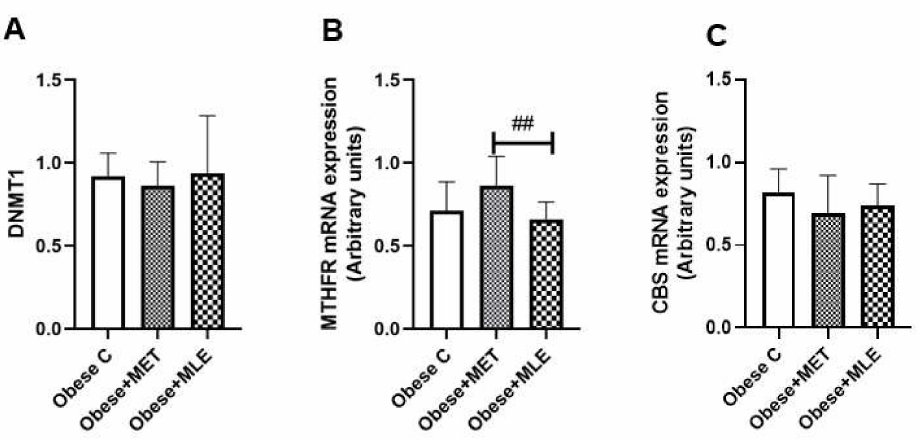
Figure 6. The effects of Marula leaf extract (MLE) on mRNA expression Dnmt1 ( A ), Mthfr ( B ) and Cbs ( C ) levels of genes involved in the control of DNA methylation. Data are represented as means ± SEM, with a sample size of 5-6/group. GraphPad Prism 9 was used to test for statistical significance at a p -value ≤ 0.05. Note: ## p ≤ 0.01 vs. obese + MET. Dnmt1 ; DNA methyltransferase 1, Mthfr ;